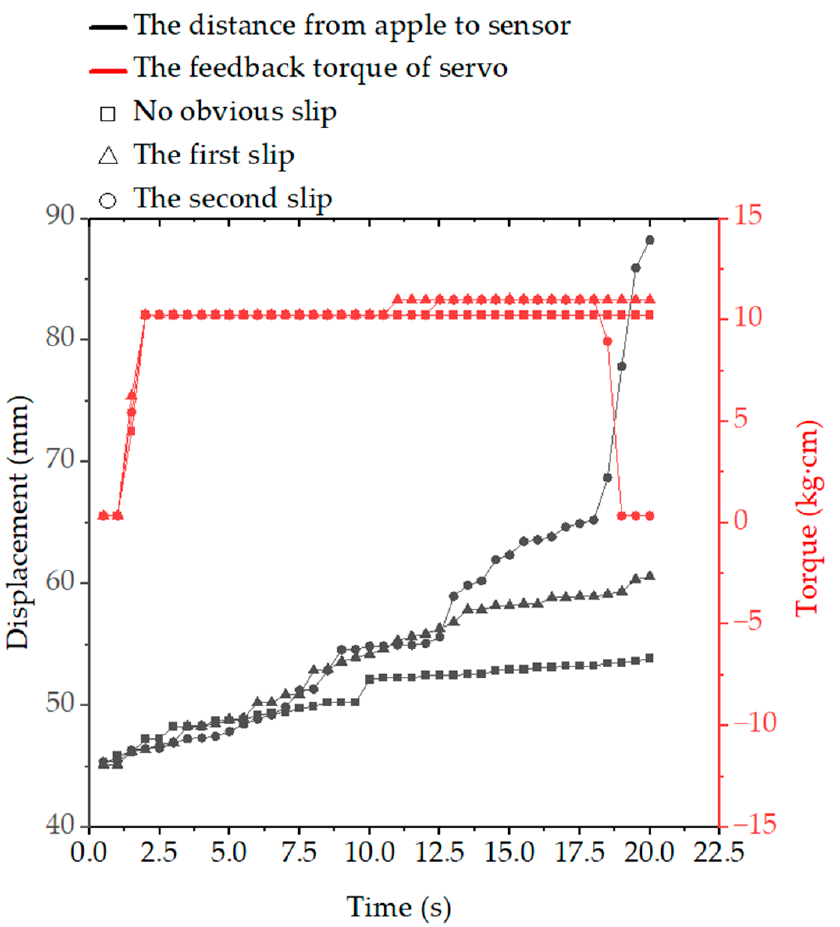
Figure 26. The slip condition of the fruit and the change of the output torque with time.